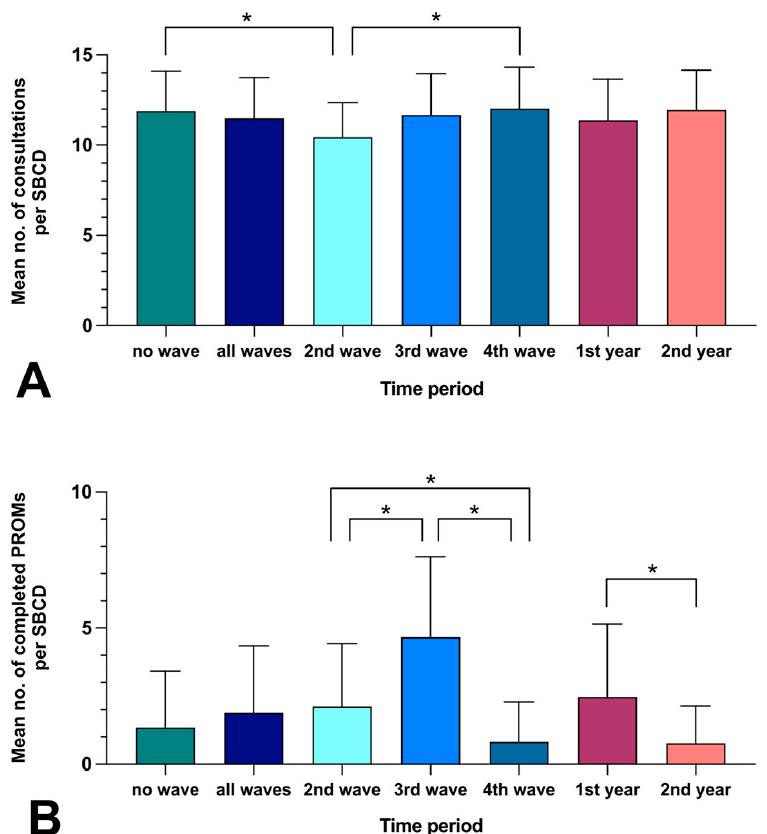
Figure 2. Analysis of the conduction of PROMs in relation to the COVID-19 pandemic. no. = number, * = statistically significant difference ( p < 0.05), ( A , B ): Comparison of the mean number (with standard deviation) of ( A ) consultations per “skull base consultation day” (SBCD) or of ( B ) completed PROMs per SBCD (in relation to the total of 96 SBCDs), illustrated for the 13 months during COVID-19 waves (“all waves” or subdivided into “second wave” (2nd wave), “third wave” (3rd wave), and “fourth wave” (4th wave)) and the 11 months beyond COVID-19 waves (“no wave”), and illustrated for the “first year” (1st year) and “second year “ (2nd year) after implementation of